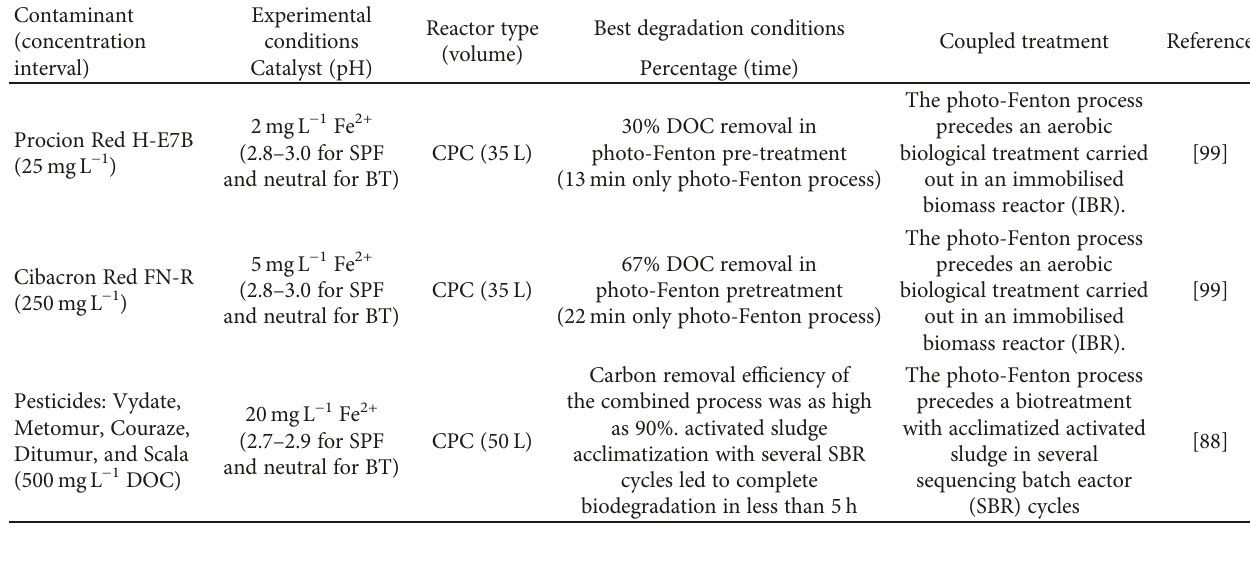
Table 3: Solar photo-Fenton coupled with other treatment